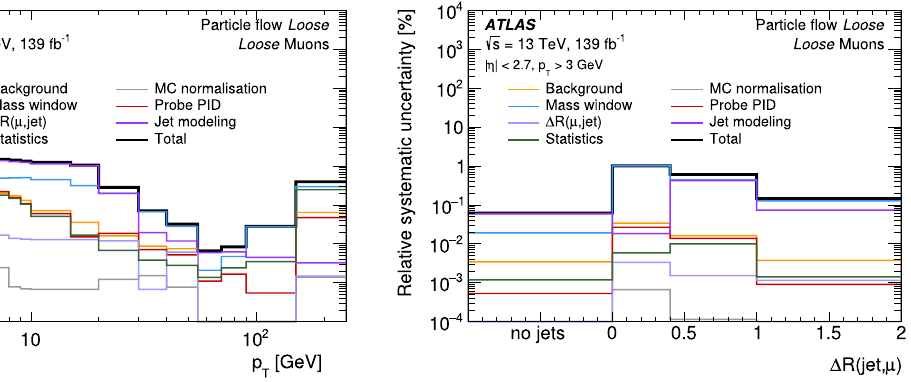
Template shape , (cid:15) - SC , and Background fit uncertainties, whereas the Fig. 9 Relative contributions to the systematic uncertainty in the effi- MC normalisation comprises the Cross-section and Luminosity uncer- ciency SFs for the PflowLoose isolation criteria, measured with Z → (cid:8) R ( jet ,μ) (right) for muons μμ decays, as a function of p tainties. The total uncertainty is the sum in quadrature of the individual T (left) and with p T > 3 GeV, and integrated over the other kinematic observables. contributions The uncertainty depicted as Background is the sum in quadrature of the